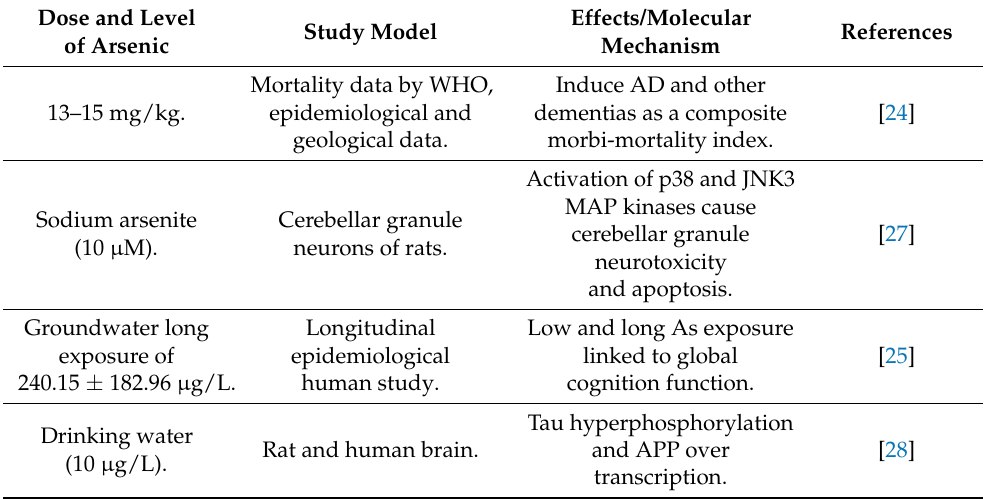
Table 1. Environmental arsenic factors highly related with AD